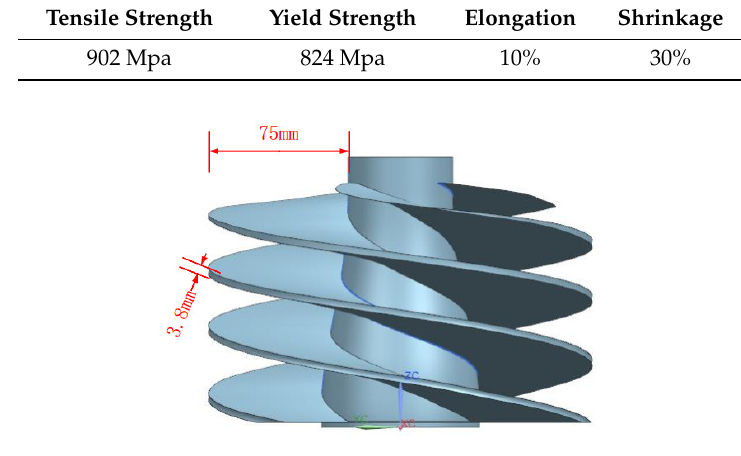
Table 2. Physical and mechanical properties of titanium alloys.